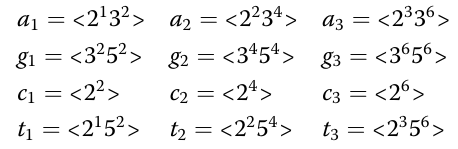
i . Similarly, the color codes of GCC, GCG,